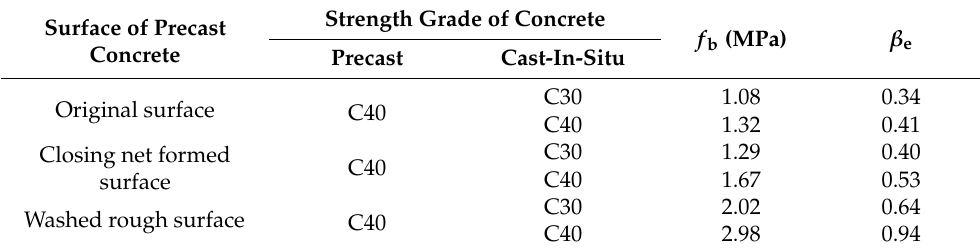
Table 8. Bonding strength of interface with different surface of precast concrete.